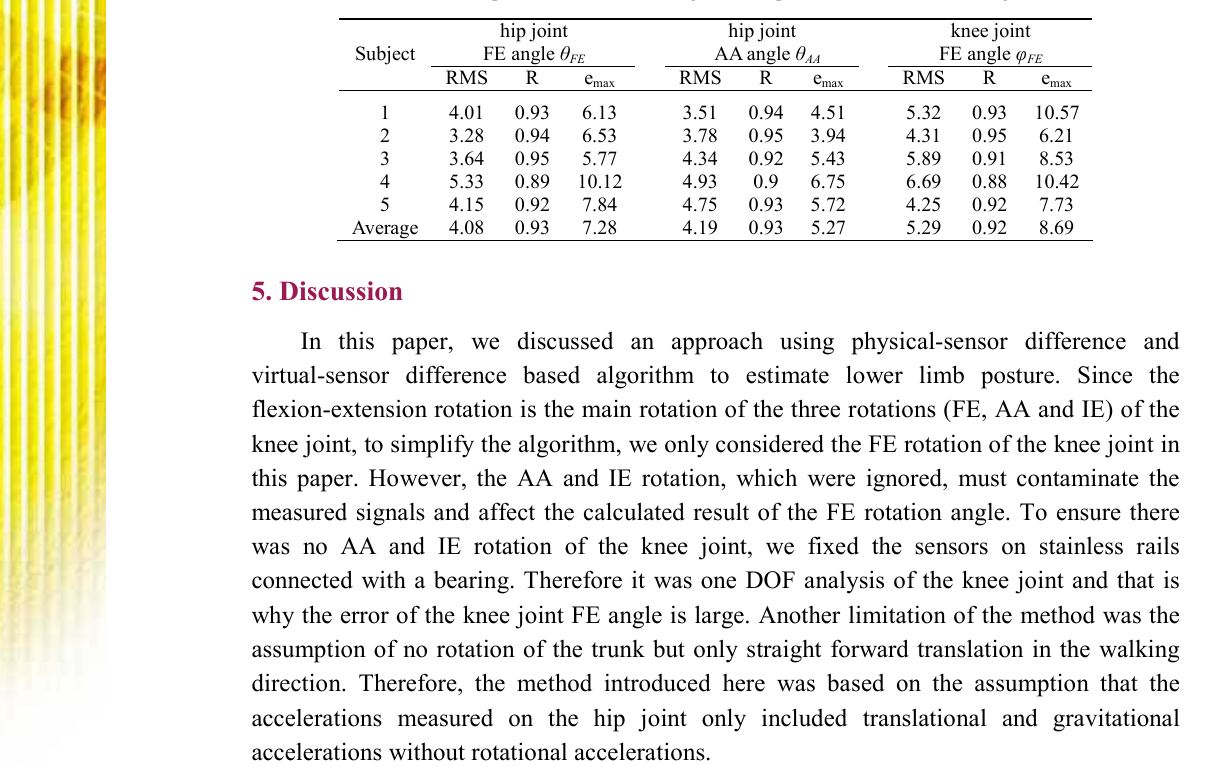
Table 2 Analysis result of the rotation angles of the hip and knee joints which were obtained from the referenced system and the wearable sensor system. The value of each parameter is an average of three trials when each subject walked at three self-selected speeds. The overall average of each parameter in five trials was given at the